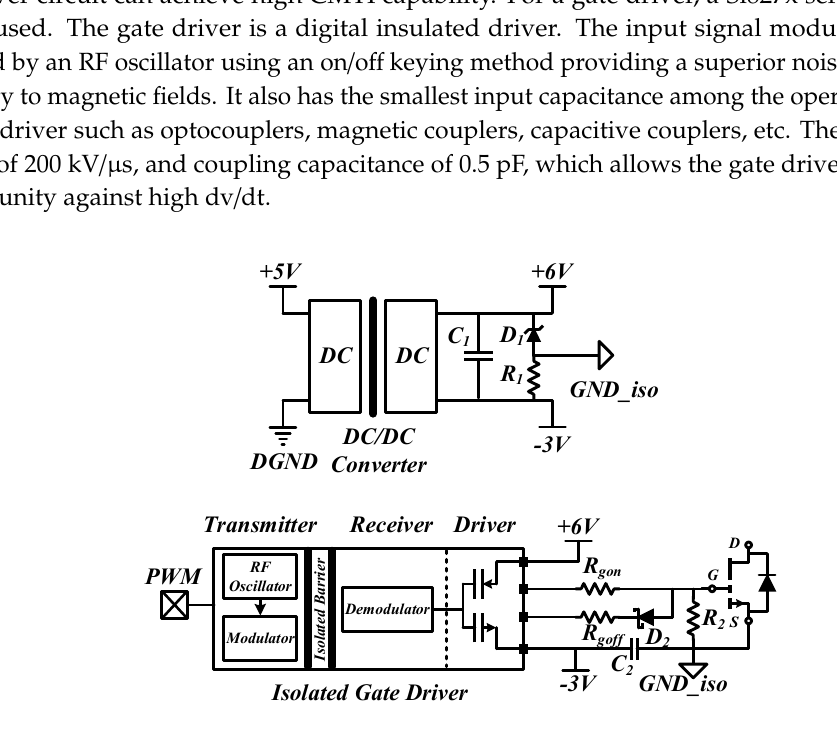
Figure 2. Proposed gate driver schematic for GaN high electron mobility transistor (HEMT).